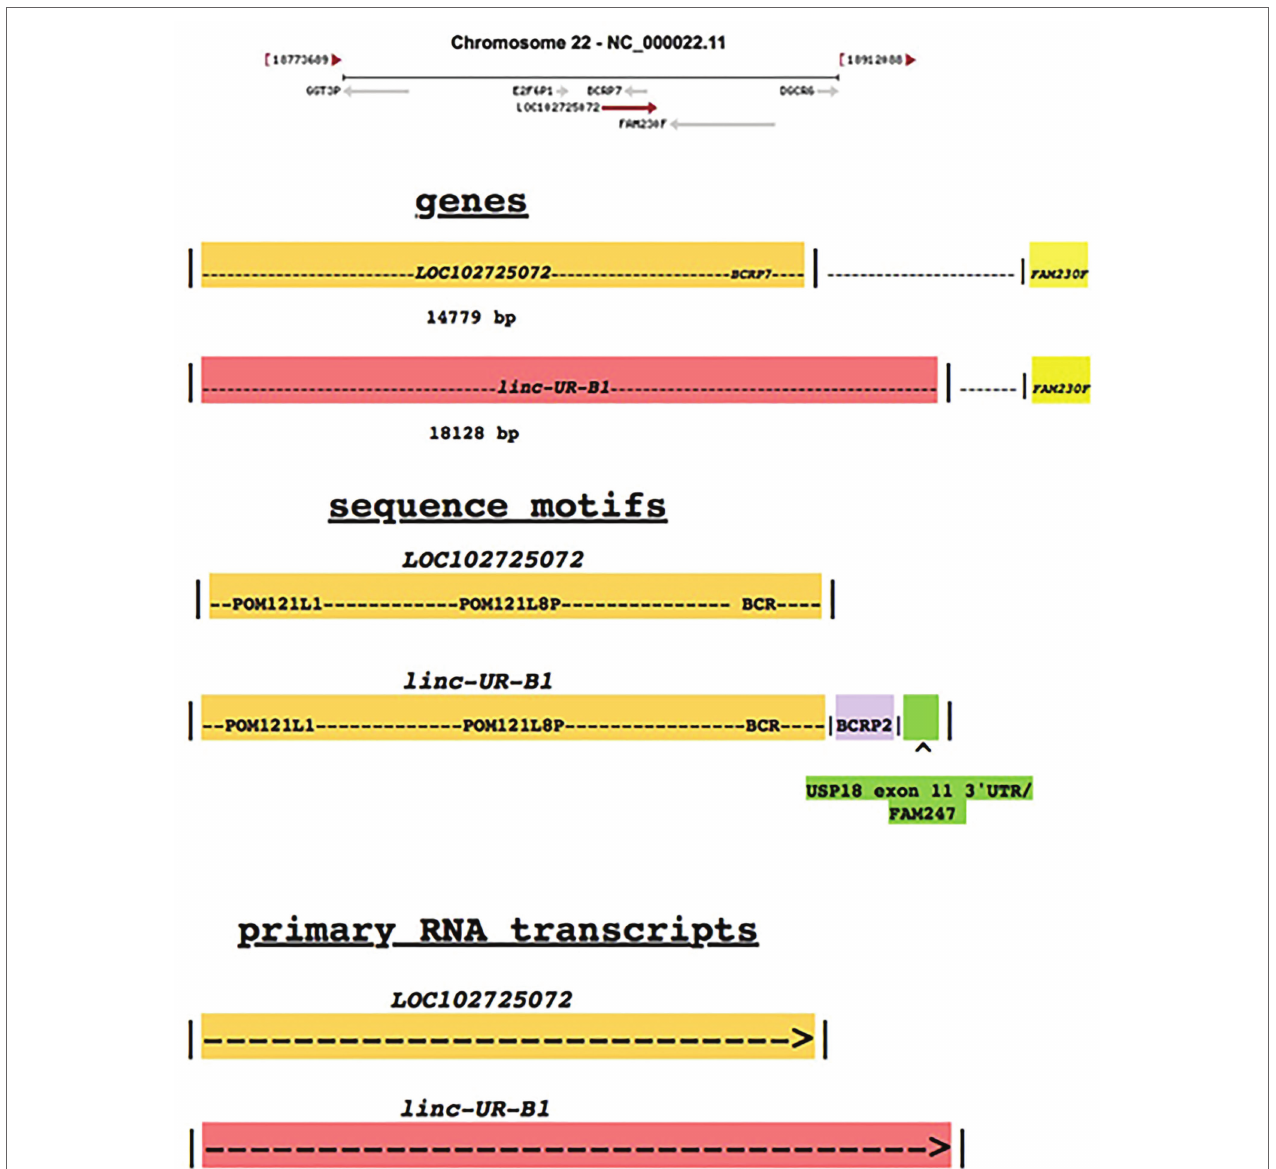
FIGURE 1 | Comparison of LOC102725072 and linc-UR-B1 . Top diagram: Annotated genes that neighbor LOC102725072 in human chr22 with chromosomal coordinates of the genomic segment shown. The schematic is from the NLM/NCBI website: https://www.ncbi.nlm.nih.gov/gene/?term=LOC102725072 (O’Leary et al., 2016). Bottom highlighted diagrams: The BCRP7 gene is a counter transcript within the LOC102725072 gene. LOC102725072 consists of the sequence of the paralogs gene POM121L8P and the POM121L1 ( LOC102724151 ) sequence at its 5 ' end that is carried by POM121L8P ; and in addition, a segment of the BCRP2 gene that carries a portion of the 3 ' end of the BCR gene ( Supplementary Figure S1 ). The BCRP2 sequence extends from BCRP7 to the 3 ' end of LOC102725072 (and beyond) and is contiguous with the BCRP7 sequence. The lower diagrams represent the linc-UR-B1 gene and the signature gene/sequence motifs that LOC102725072 and linc-UR-B1 contain. Also shown are the bp lengths of the genes. The BCRP2 gene sequence (of which 2,124 bp of the sequence resides beyond the 3 ' end of LOC102725072 ) forms part of linc-UR-B . In addition, 1,225 bp of a homologous sequence to FAM247 is also in linc-UR-B1 , which contains the USP18 exon 11 3 ' UTR sequence but also contains additional sequences of FAM247. POM121L1 is the putative POM121 transmembrane nucleoporin like 1 protein gene LOC10272415 but has not yet been characterized outside of computational methods. The diagrams are not drawn to